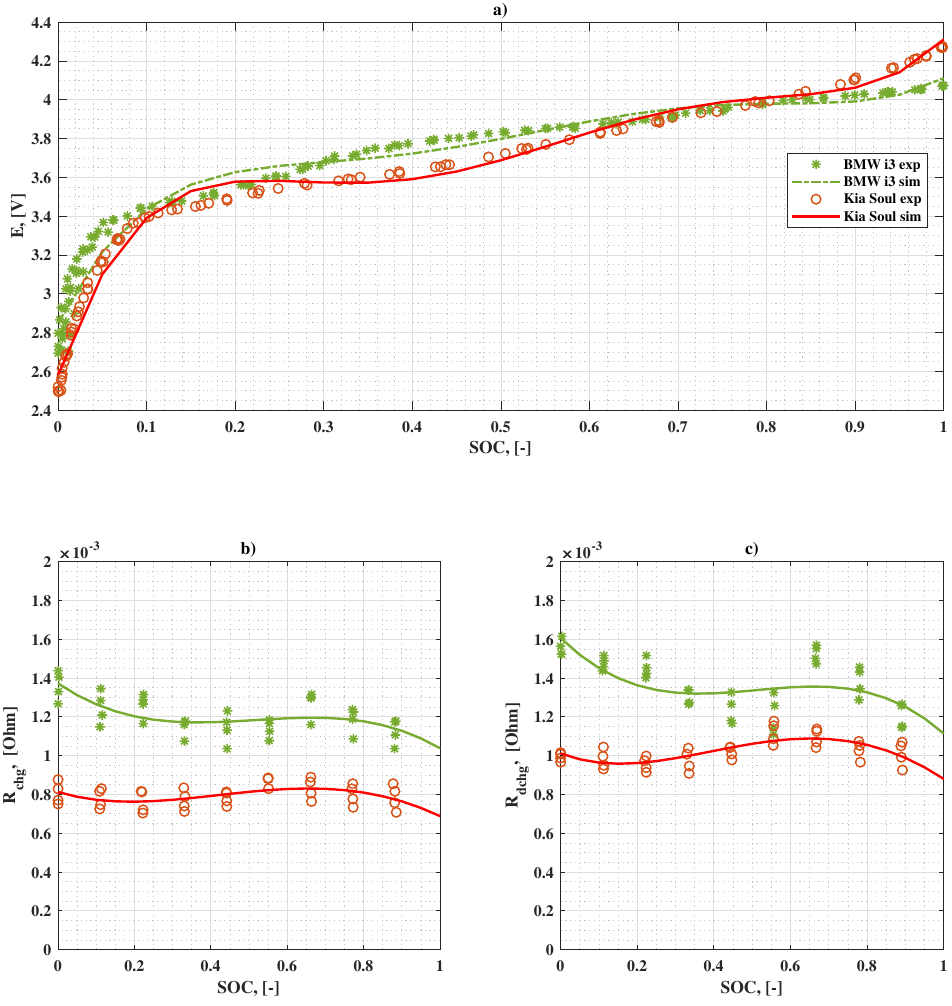
Figure 4. Variation of battery cell parameters as functions of battery SOC [34,35]: ( a ) Open circuit voltage E ; ( b ) R chg ; and ( c ) R dchg